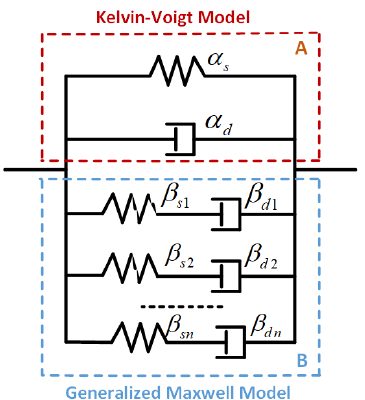
Figure 5. The Kelvin-Voigt-Generalized Maxwell (KV-GM) model.